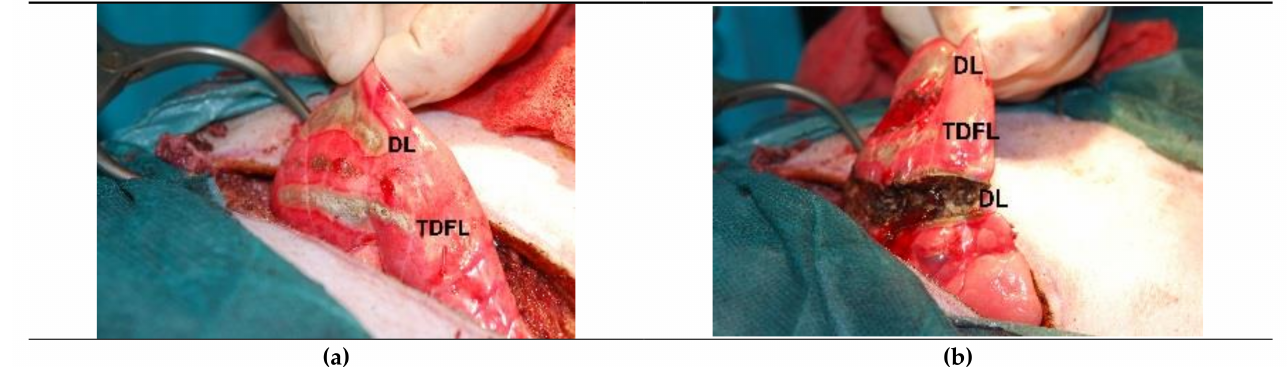
Figure 1. Intraoperative view of the lung: ( a ) Incisions with the diode laser (DL) and thulium-doped fiber laser (TDFL); ( b ) partial resection of the lung with the DL and incisions with both lasers above.